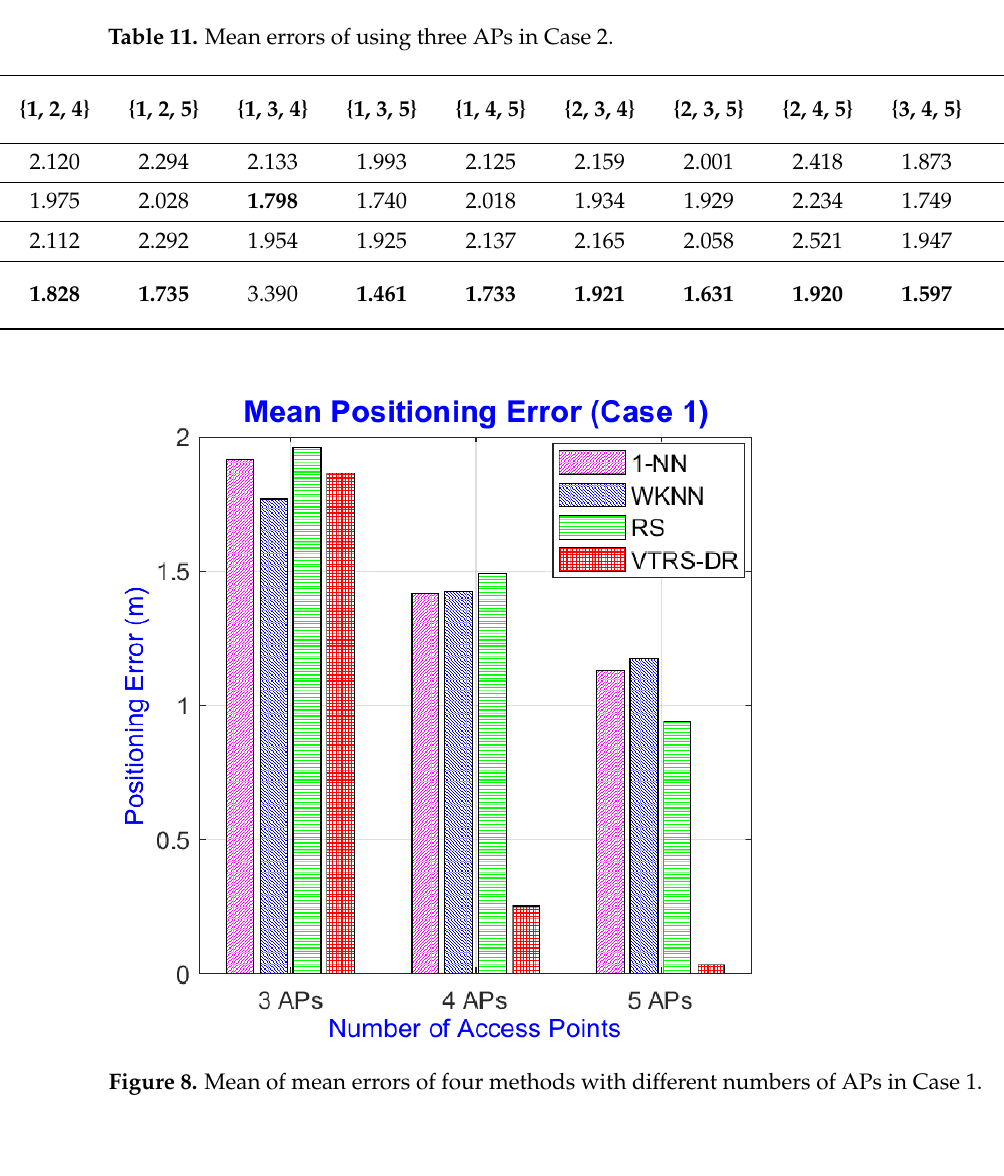
Figure 9. Mean of mean errors of four methods with different numbers of APs in Case 2.